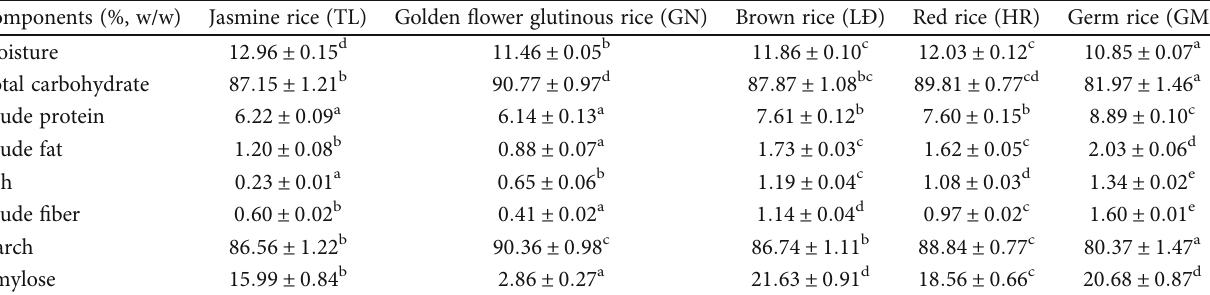
Table 2: Chemical composition of rices 1